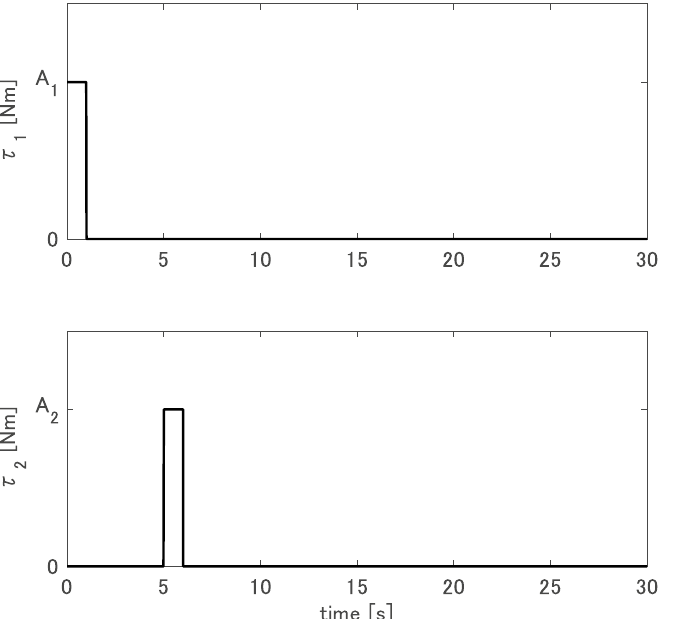
Figure 2. Waveform of the input torques.